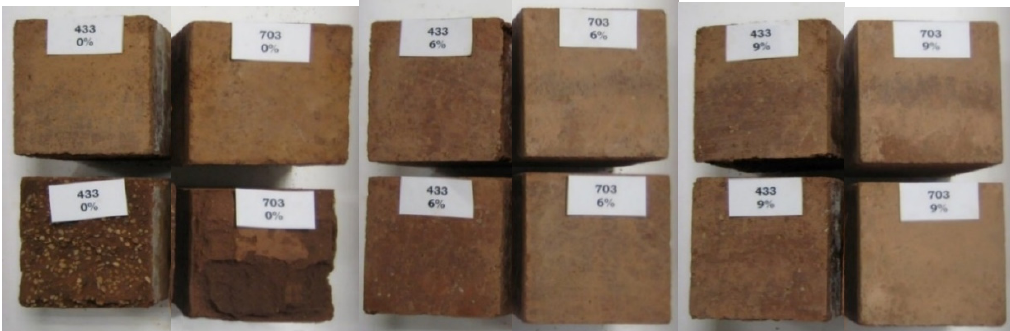
Figure 8. Comparison of samples tested for cyclic moisture and drying (lower row) with their control equivalents (upper row). Table 7. Final results of the water erosion resistance test.